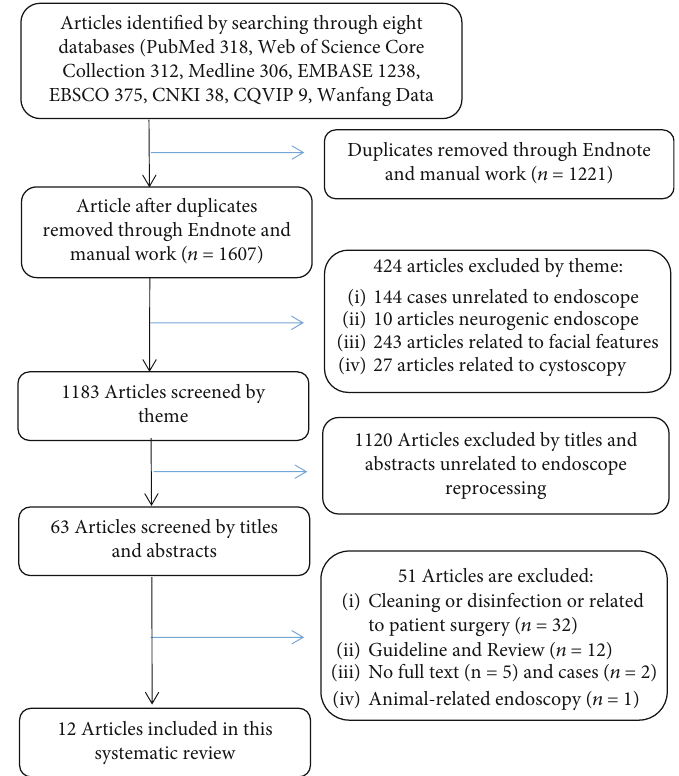
Figure 1: Flow diagram of articles included in the systematic